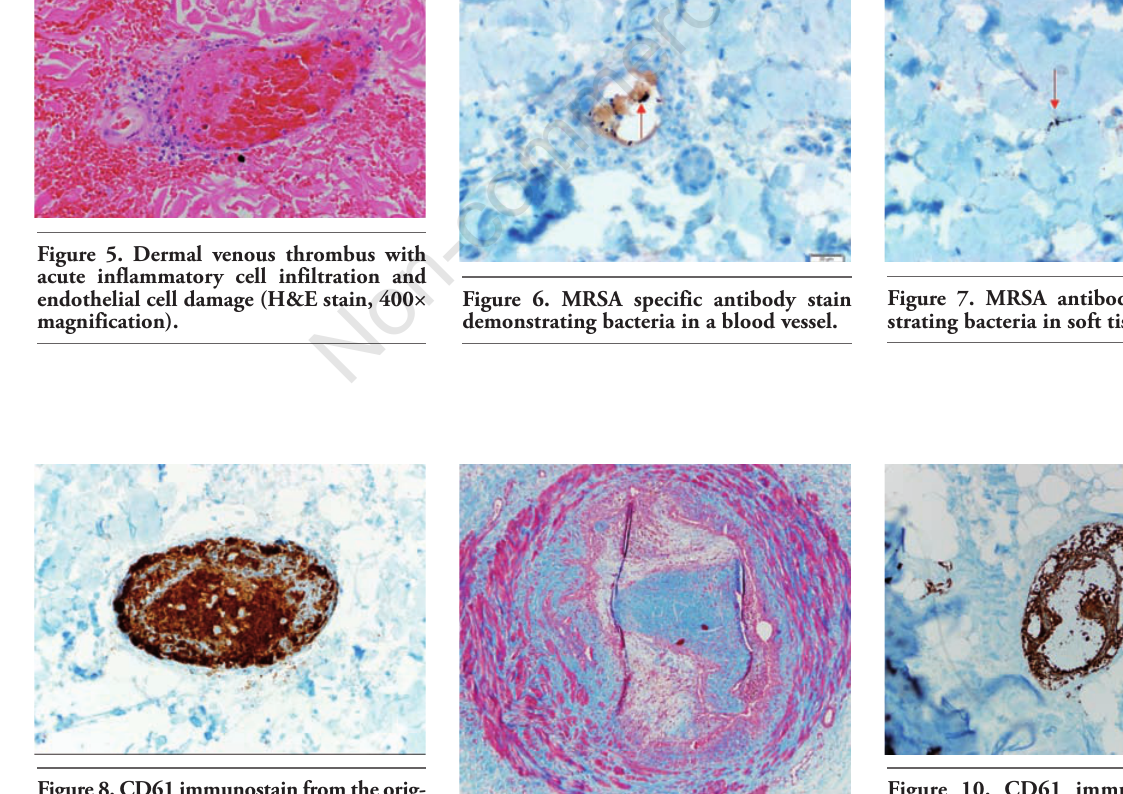
Figure 8. CD61 immunostain from the orig- inal lesion